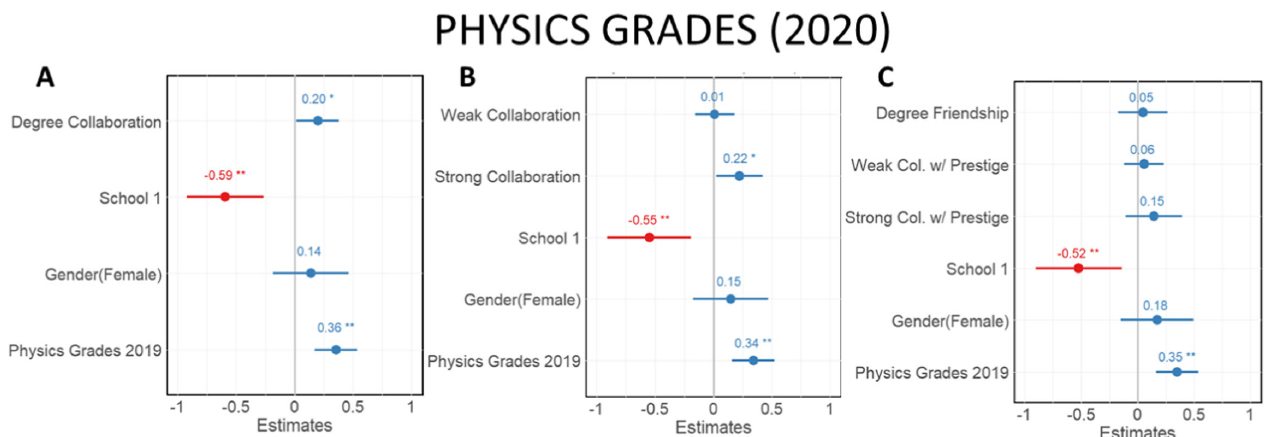
FIG. 3. Graphic depiction of OLS multiple linear regression models for physics grades regressed on collaborative variables: Degree collaboration, model A; weak and strong collaboration, model B, and weak and strong collaboration with high prestige in physics, model C. Models include confounding variables: School 1 (factor); female students (gender as a factor); physics grade in 2019 (previous academic year); and degree friendship. Positive coefficients are depicted in blue, while red coefficients indicate negative